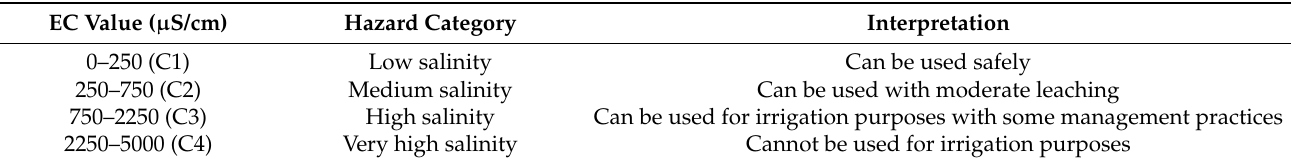
Table 6. Salinity hazard zones: based on EC.